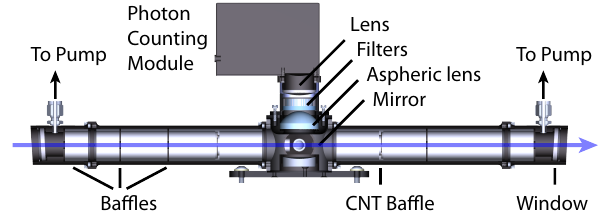
Figure 4. This diagram shows a side-view of the cross-section of the detection cell. The blue line indicates the laser path and propagation